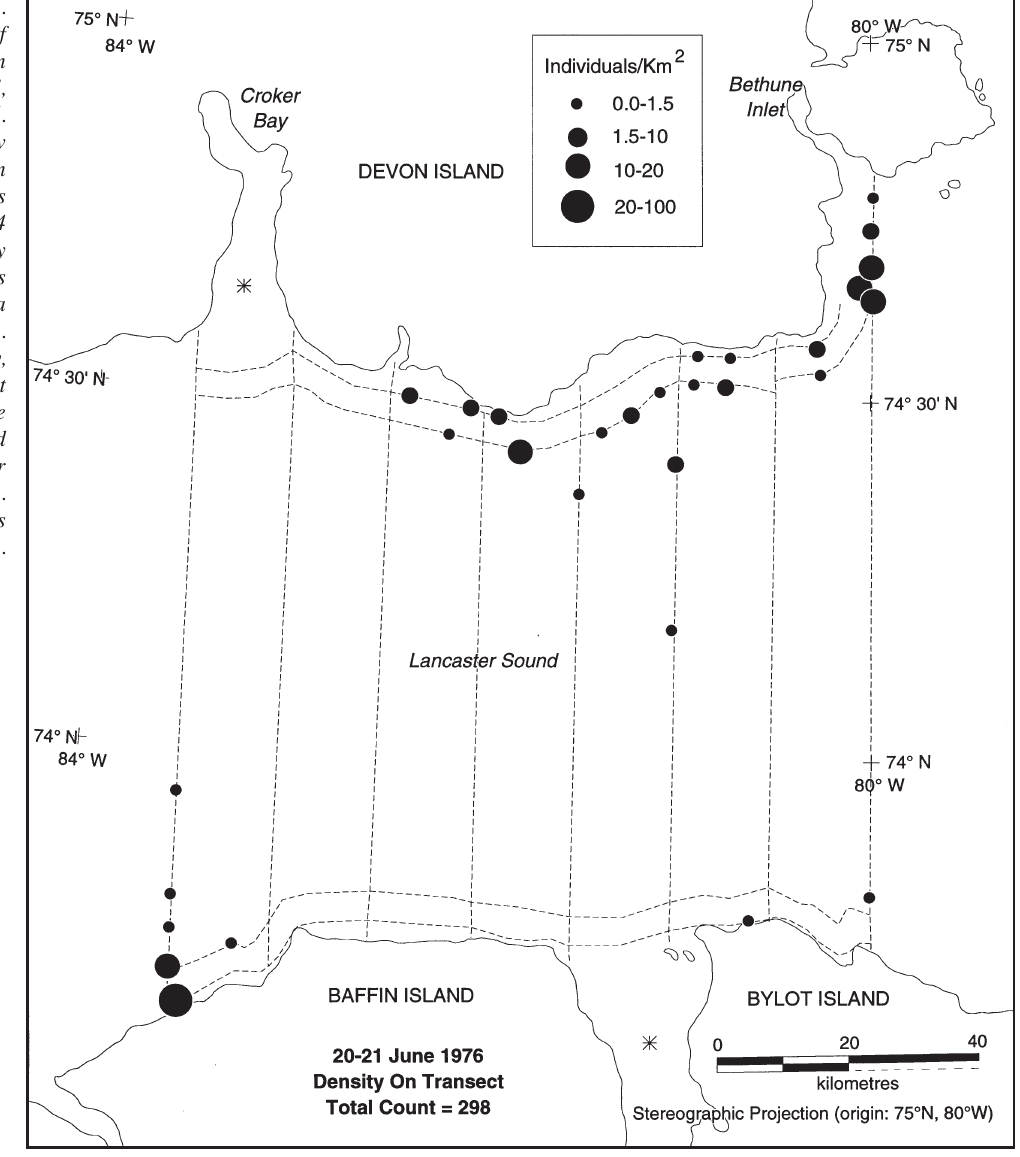
Fig. 4 . Distribution of belugas in eastern Lancaster